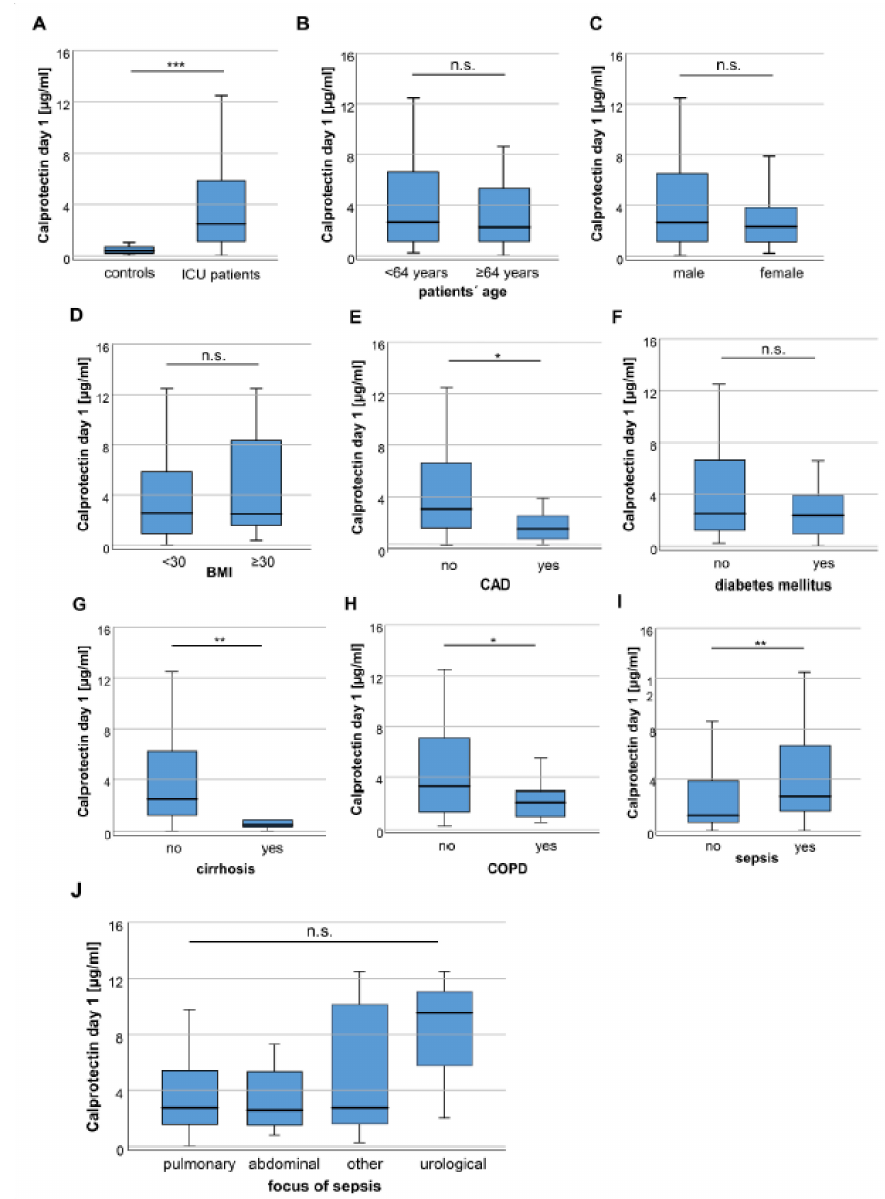
Figure 1. Calprotectin serum concentrations are significantly higher in critically ill and sepsis patients. ( A ) Critically ill patients at admission to the ICU have significantly lower calprotectin serum concentrations compared to healthy controls. ( B ) Calprotectin serum concentrations did neither di ff er between patients younger or older than 64 years nor between male and female patients ( C ) or patients with a body mass index (BMI) below or above 30 ( D ). ( E ) Patients with coronary artery disease (CAD) but not diabetes mellitus ( F ) showed significantly lower calprotectin concentrations. ( G ) Patients with liver cirrhosis or chronic obstructive pulmonary disease (COPD) ( H ) also had significantly lower calprotectin serum concentrations at day 1 of ICU admission. ( I ) Calprotectin concentrations are significantly increased in patients admitted due to sepsis compared to patients without. ( J ) Di ff erent sites of infections in patients with sepsis did not result in significantly di ff erent serum concentrations of calprotectin. * p < 0.05; ** p < 0.005; *** p < 0.001, n.s.: not